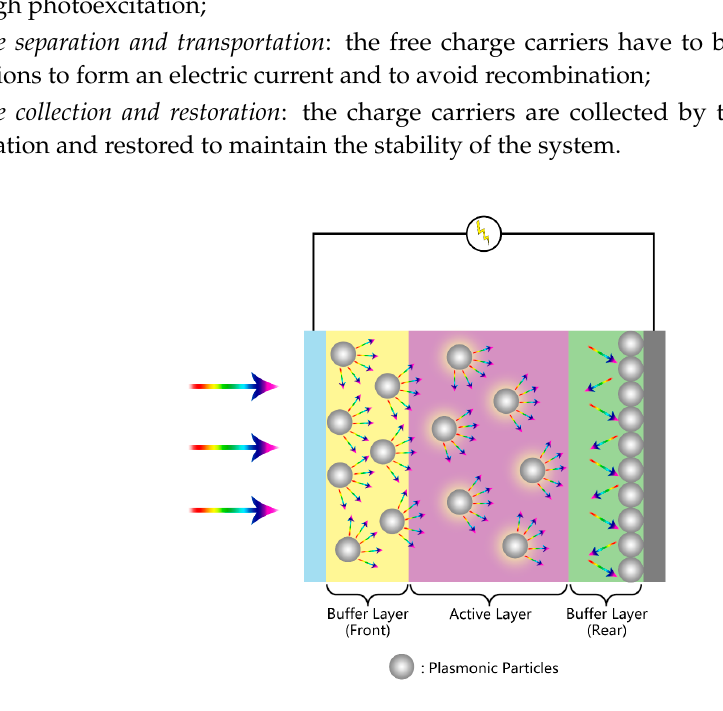
Figure 5. Mechanisms of plasmonic enhanced Si/polymer photovoltaics.